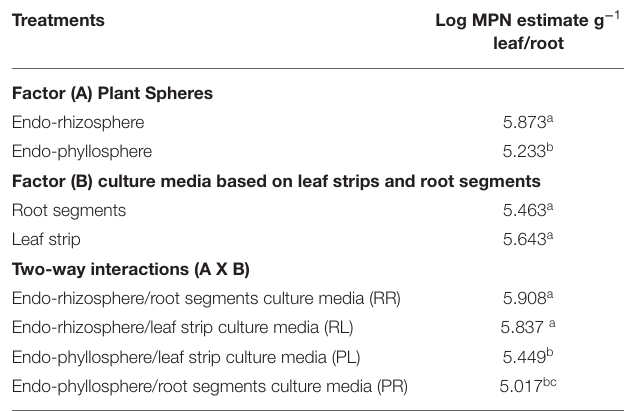
TABLE 3 | MPN estimates of bacteria of endo-rhizosphere/endo-phyllosphere of sunflower plants as developed on leaf-strips/root segments- based semi-solid culture media, under limited oxygen conditions: two-way ANOVA